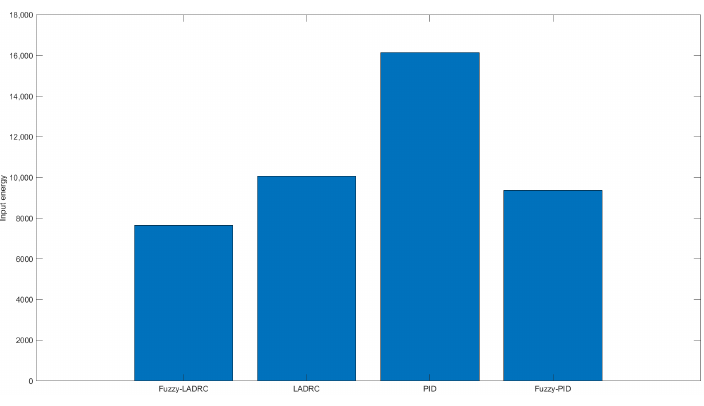
Figure 12. The input energies of u ( t ) . According to Figure 12, the proposed control scheme minimizes the input